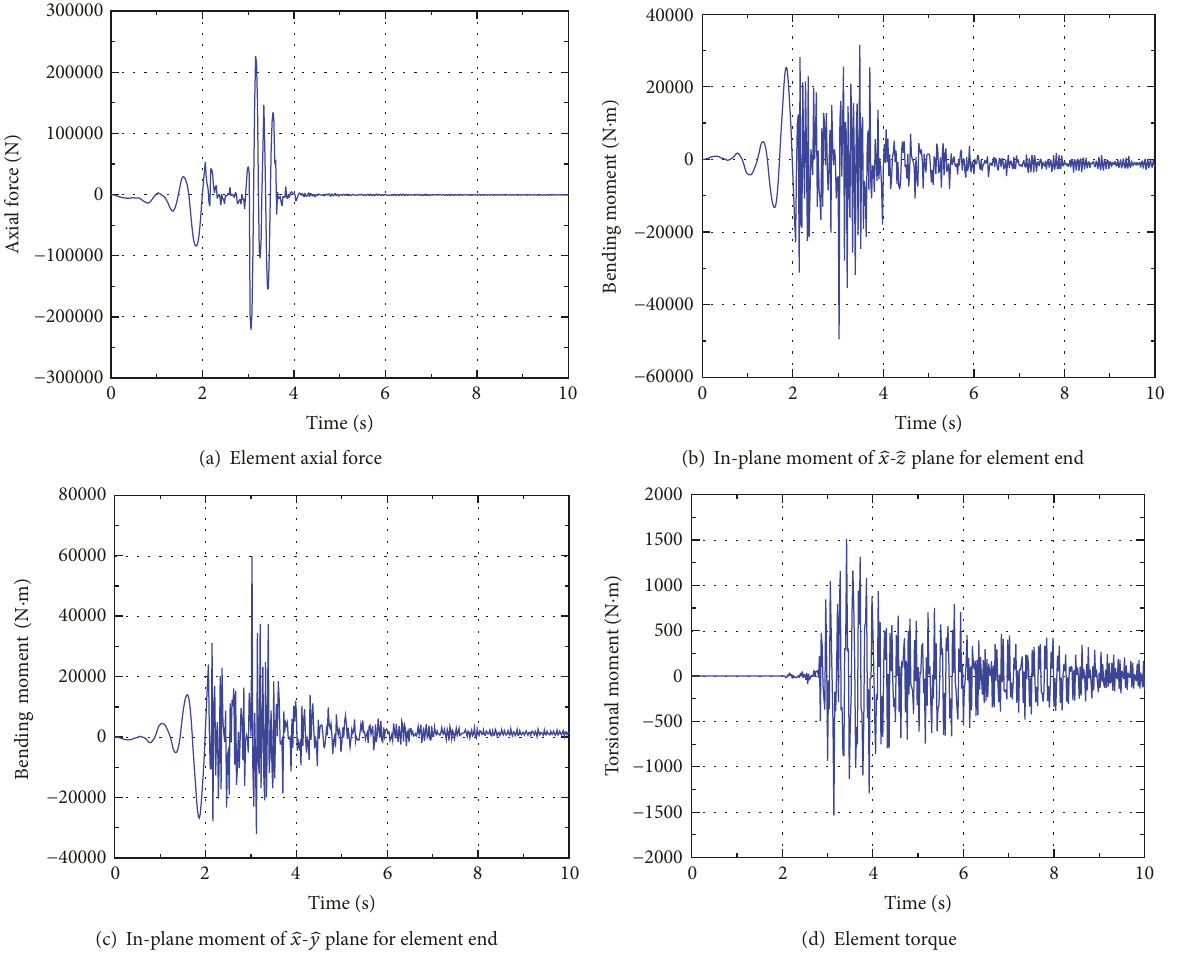
Figure 32: Internal force time history curve of element 2.